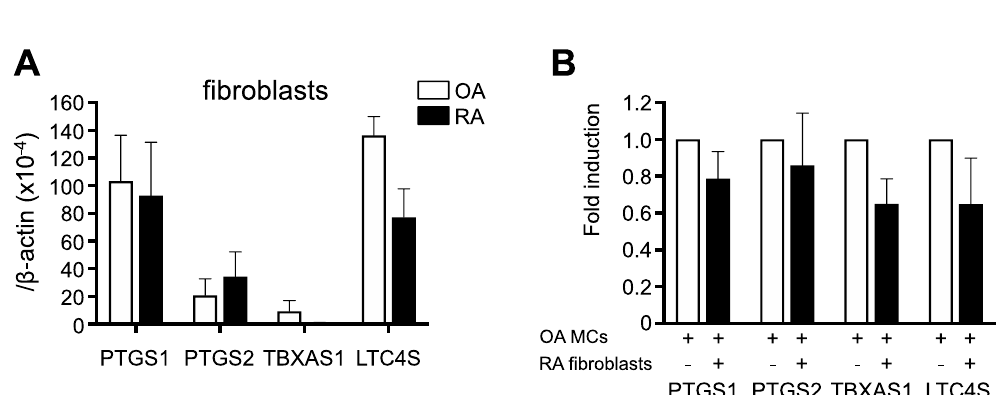
Figure 3. PGD 2 induced IL-8 production by human group 2 innate lymphoid cells (ILC2s). IL-8 ( A ), IL-6 ( B ), TNF-α ( C ) and IL-9 production ( D ) by ILC2s in response to PGD 2 . The results are the mean ± SEM for three different donors. Significance was determined by Sidak’s-Bonferroni test (* P < .05, ** P < .01, and **** P < .0001). N.D. means not detected (below the level of detection).